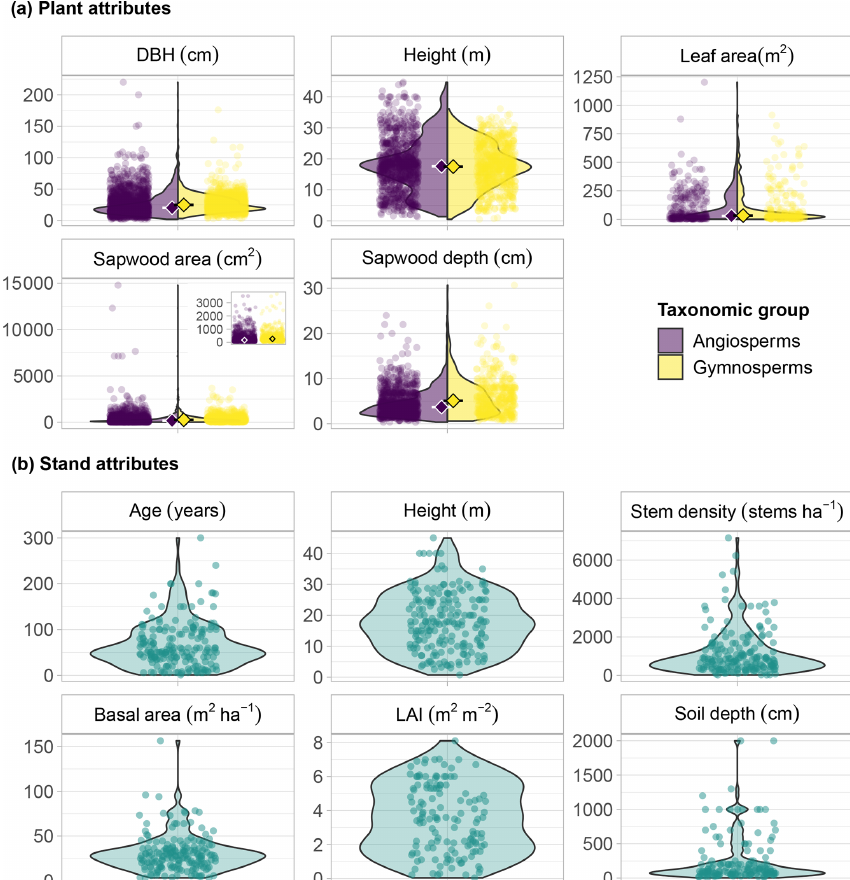
Figure 5. Characteristics of trees and stands in the SAPFLUXNET database. Panel (a) shows plant data and kernel density plots of the main plant attributes, coloured by taxonomic group (angiosperms and gymnosperms): diameter at breast height (DBH), plant height, sapwood area, sapwood depth, and leaf area. The inset in the sapwood area panel zooms in on values lower than 5000cm 2 . Panel (b) shows stand data and kernel density plots of the main stand attributes: stand age, stand height, stem density, stand basal area, leaf area index (LAI), and soil